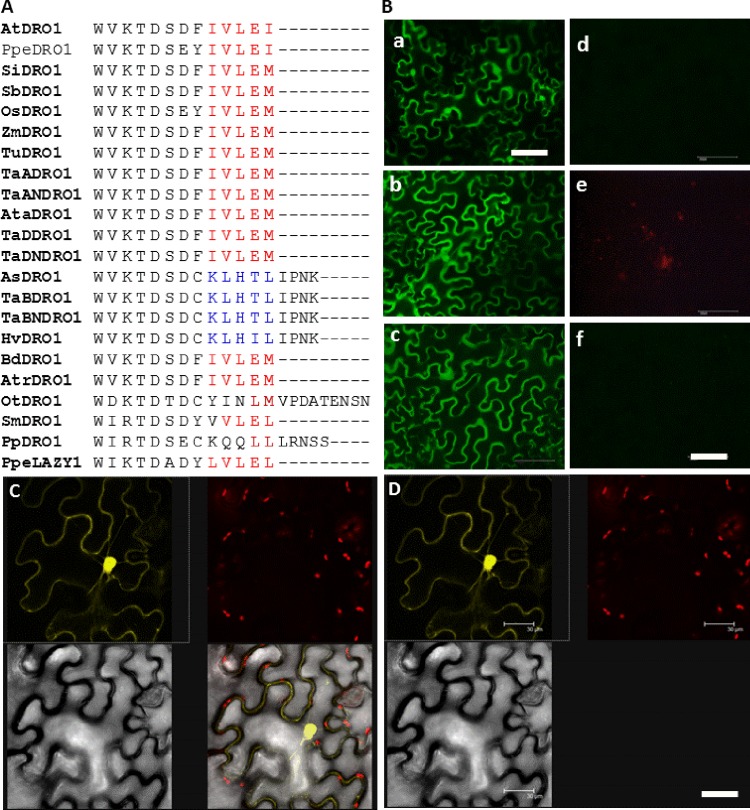
Recruitment of EAR-like motif in interaction of DRO1-like proteins with TOPLESS.(A) Amino acid sequence alignment of the 5th domain of the DRO1-like proteins of Tritici, Aegilops, Hordeum, Brachypodium, monocot cereals, Arabidopsis, Prunes, Oropetium thomaeum, Amborella, Selaginella, Physcomitrella and LAZY1 of Prunus is shown. The EAR-like motif is highlighted in red letter while blue residues depict an EAR-like motif in AsDRO1-like, TaBDRO1-like and HvDRO1-like with addition of IPNK residues. (B) Bimolecular fluorescence complementation analysis. Protein-protein interactions studies of DRO1-like homoeologs with TOPLESS (TPL) protein were carried out in Nicotiana benthamiana using Split-YFP analysis. Leaf tissues of Nicotiana infiltrated with full-length CDS of TaADRO1-like, TaBDRO1-like and TaDDRO1-like constructs as well as with truncated versions i.e., TaADRO1-likeΔ246, TaBDRO1-likeΔ245 and TaDDRO1-likeΔ246 were scanned for detection of YFP signals using Nikon Digital SIGHT DS-i2, ECLIPSE Ni- fluorescence microscope. The letters a, b and c on the left depict the YFP signals with full length CDS of TaADRO1-like, TaBDRO1-like and TaDDRO1-like, respectively while d, e and f show that YFP signals are vanished with truncated version of DRO1-like proteins. Scale bars represent 100 nm. (CD) Confocal Laser Scanning Microscope (CLSM) snapshots of TaBDRO1-like-TPL with white, black and chlorophyll back ground for authenticity of YFP signals.